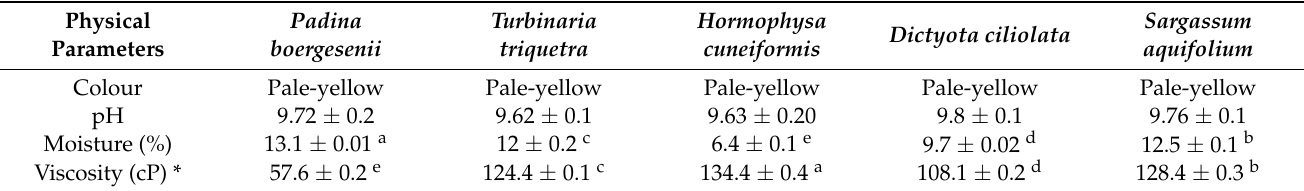
Table 2. Physical properties of sodium alginate extracted from the tested macroalgae.